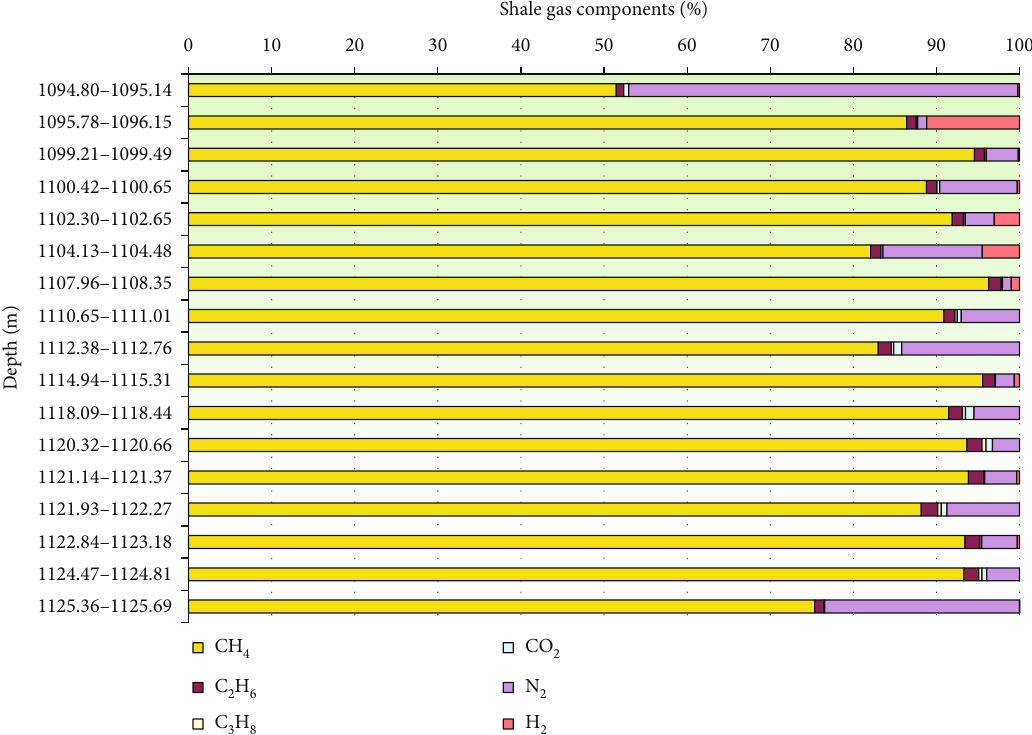
Figure 9: Analysis diagram of shale gas composition in well QD1, southeast